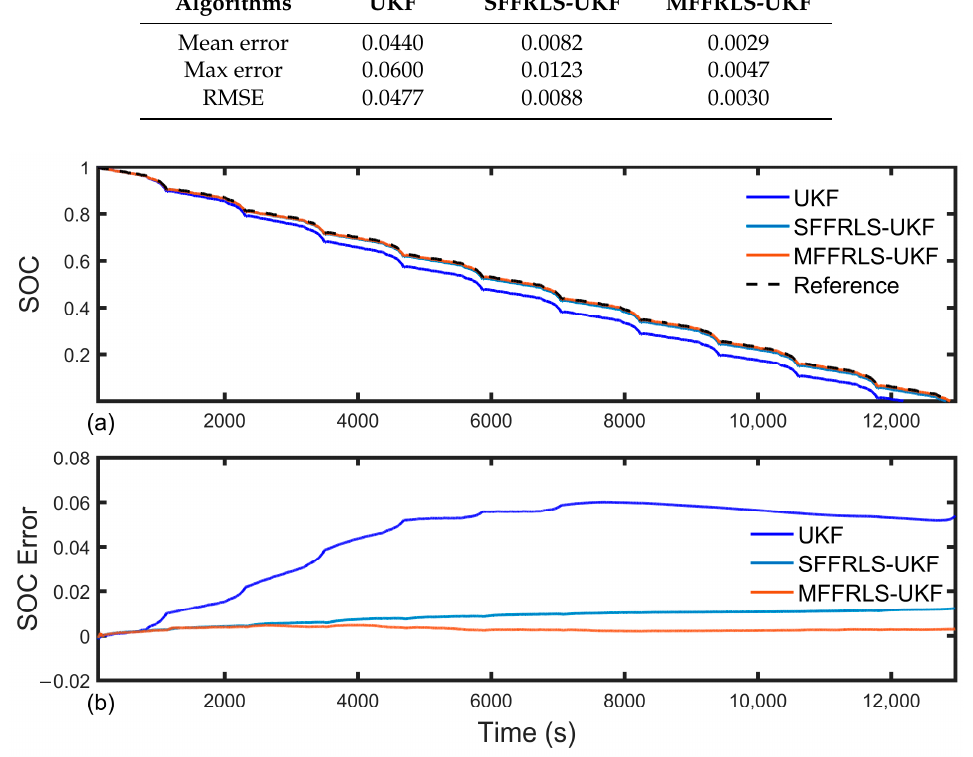
Figure 9. SOC estimation result of UKF, SFFRLS-UKF and MFFRLS-UKF during NEDC test under variable temperature: ( a ) SOC estimation; ( b ) SOC estimation error.